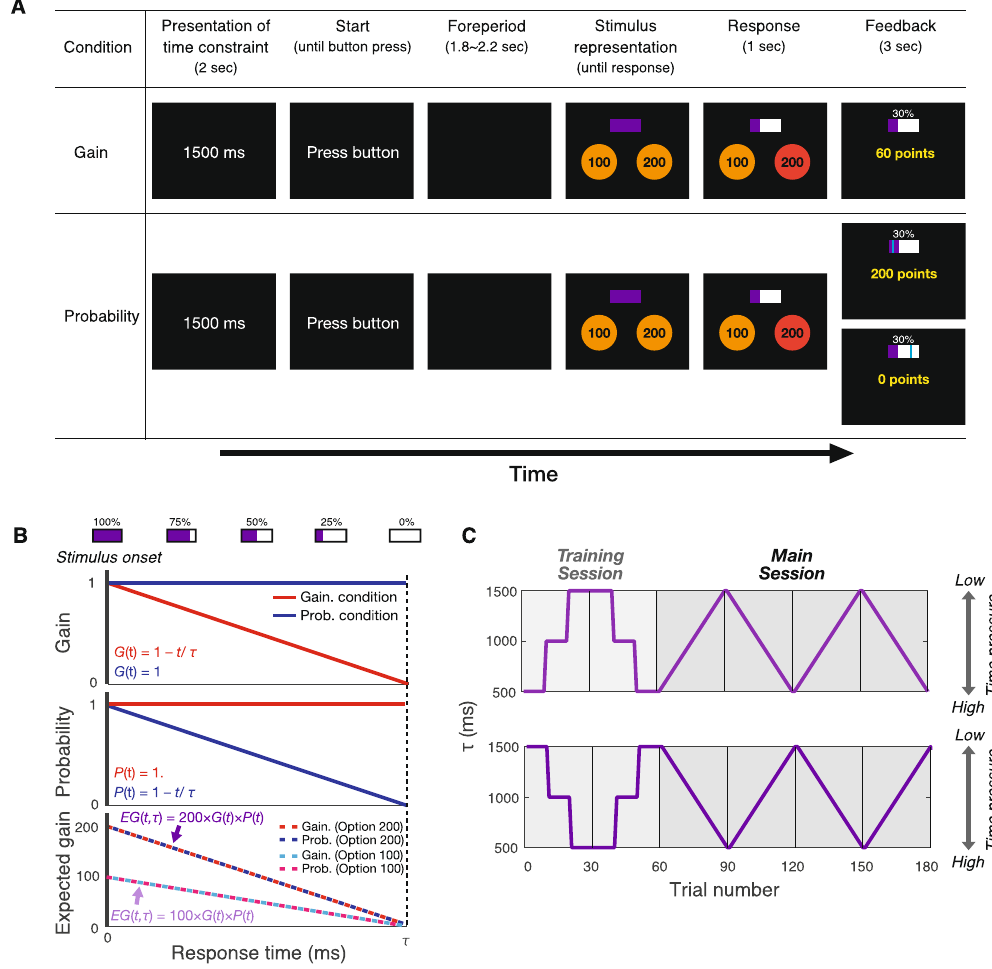
Figure 1. Experimental setup. ( A ) Task sequences of the gain and probability-decrease conditions. At the beginning of the task, time interval until gain/probability decreased to 0 ( τ ms) was presented at the center of the screen. The participants initialized a trial by pressing a button. After a random fore-period, two choice stimuli and a time bar (the purple bar) were presented. The number presented on the stimuli showed the initial values (100 or 200). Expected gain of each option decreased linearly over time from the initial values to zero points by decreasing gain or probability. The time bar showed the gain/probability at that time. Participants pressed one of two buttons corresponding to the two choice stimuli at any time. The color of the selected stimuli turned to red, after which time-discounted score [e.g., 60 points (200 points × 0.3) in panel A] and gain (e.g., 30% in panel A) were presented as feedback in the gain-decrease condition. Score (e.g., 0 or 200 points in panel A), probability (e.g., 30% in panel A), and a blue line within the range of the time bar were presented in the probability-decrease condition. The position of the blue line was determined by a uniform random number. Participants obtained scores only when this line fell within the purple area. ( B ) Gain/probability/expected gain function. The upper, middle, and lower panels show gain function, probability function, and expected gain function of each option in both conditions, respectively. When τ was the same value, the expected gain depending on time was equivalent between two conditions. ( C ) Trial sequences of τ . We used two sequences of τ and changed the sequence between conditions. In the training session, participants performed 20 trials under three levels of time pressure ( τ = 500, 1000, 1500 ms). In the main session, τ ascended or descended across trials from 500 to 1500 ms [step size of τ change was approximately 34.5 (~1000/29) ms]. The order of trial sequences of τ and condition (gain or probability) were counterbalanced among